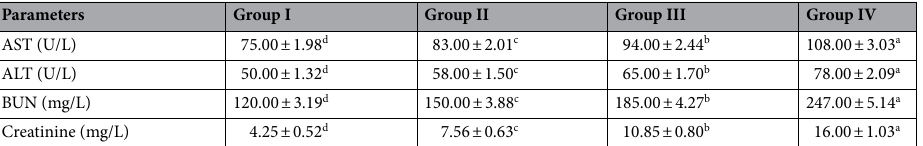
Table 2. Effects of cypermethrin on selected biochemical and oxidative stress parameters. *Group I: control, Group II: 62.5 mg/kg b.w cypermethrin, Group III: 125 mg/kg b.w cypermethrin, Group IV: 250 mg/kg b.w cypermethrin. Values are shown as mean ± SEM (n = 6). Data were analyzed with SPSS computer program using Duncan test and ANOVA variance analysis. The averages shown with different letters (a–d) on the same line are statistically significant ( p <